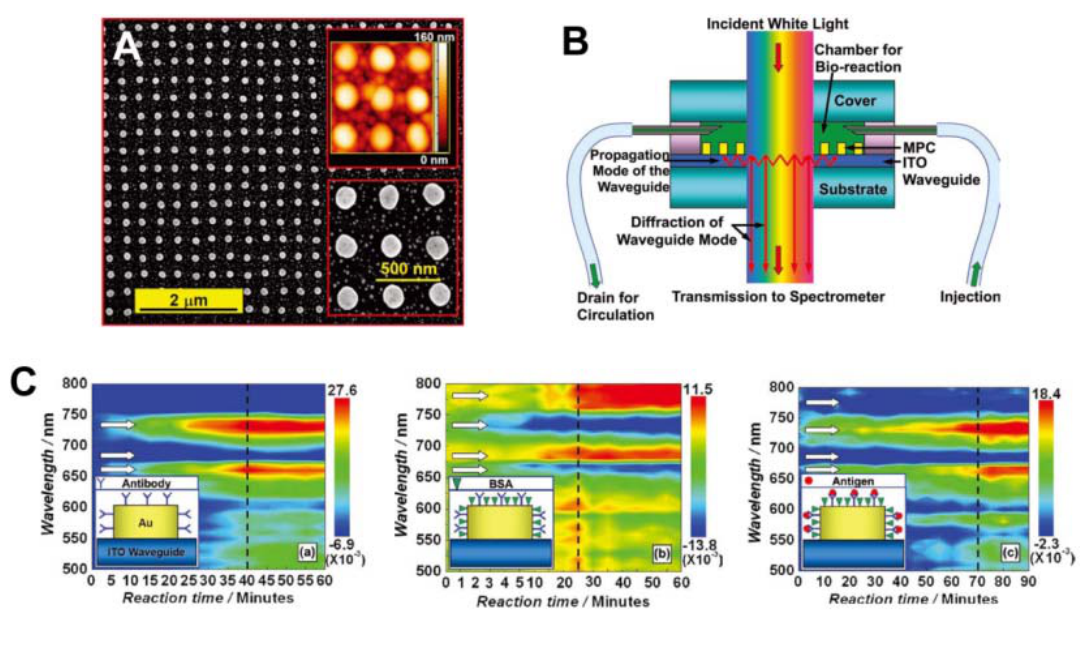
Figure 12. ( A ) SEM image of the 2D waveguided gold nanocylinders PC structures. Insets: AFM (top right) and enlarged SEM (bottom right) images. ( B )